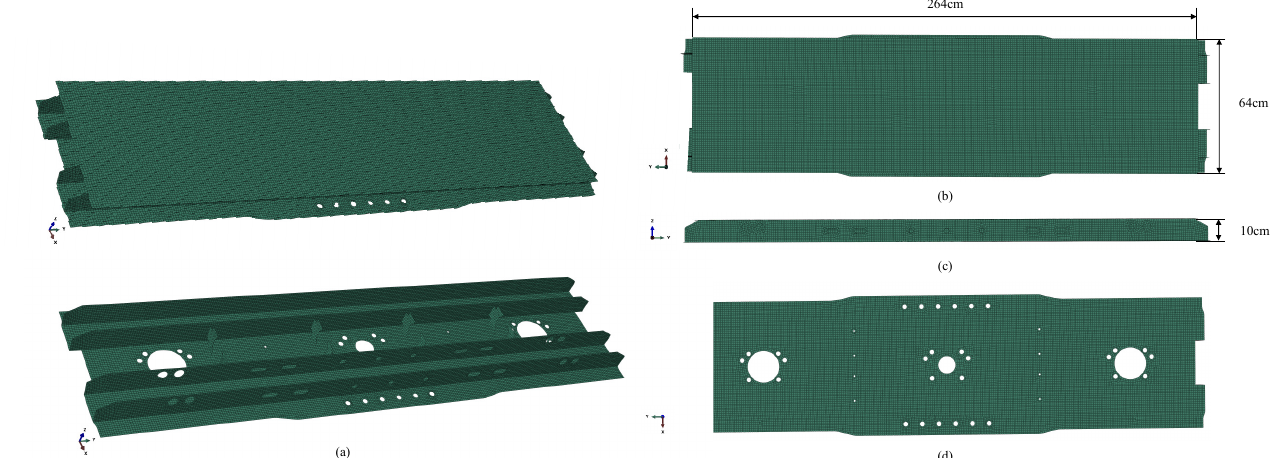
Figure 7. Schematic diagram of sleeper beam. ( a ) Overall structure of the sleeper beam. ( b ) Top view of the sleeper beam, the length of the cover plate is 264 cm and the width is 64cm. ( c ) Front view of the sleeper beam, the height of the sleeper beam is 10 cm. ( d ) The lower cover plate of the sleeper